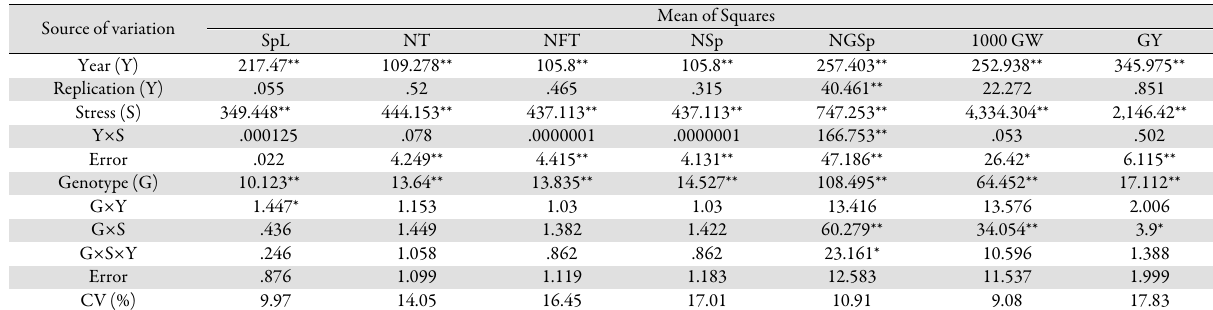
Source of variation